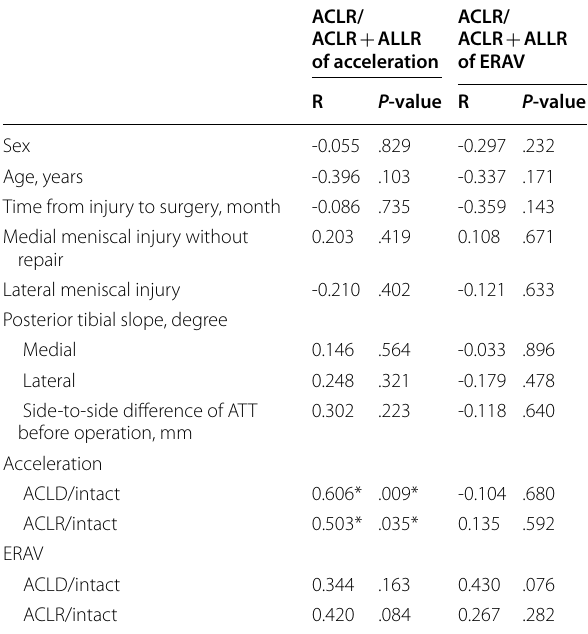
ALLR for acceleration +